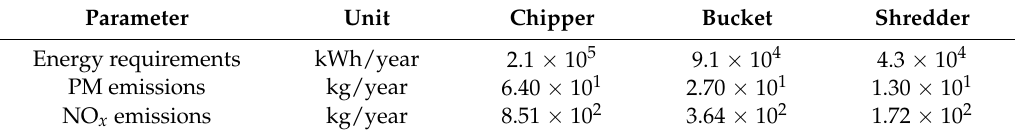
Table 1. Annual consumption and emissions in the wood chip production step. PM: particulate